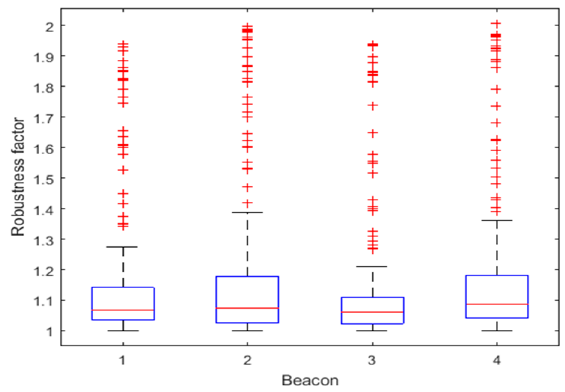
Figure 20. Distributions of robustness factors for the four Beacons for Route 2.